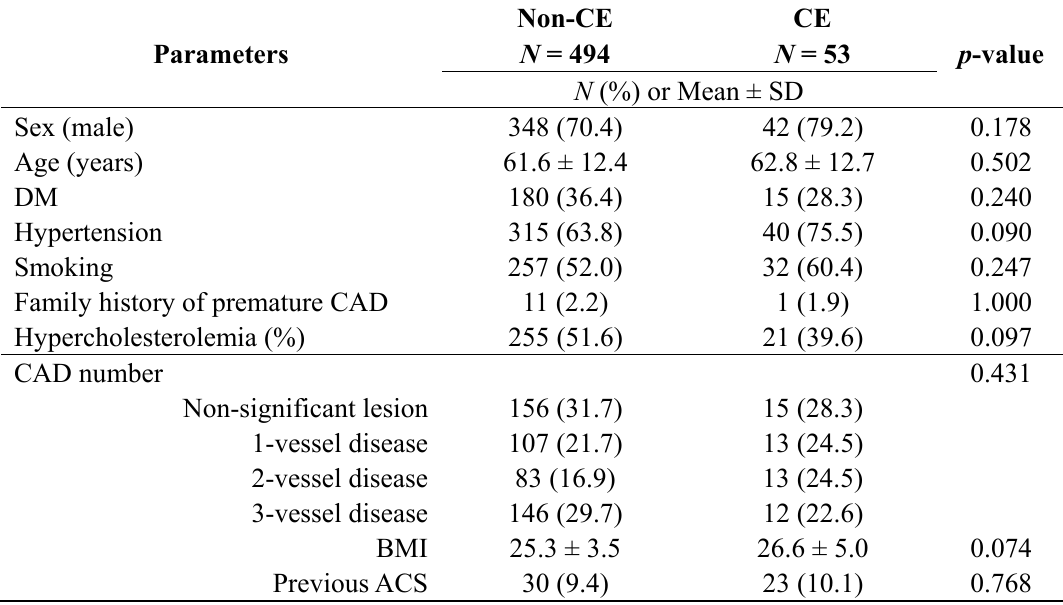
Table 1. Patients’ baseline